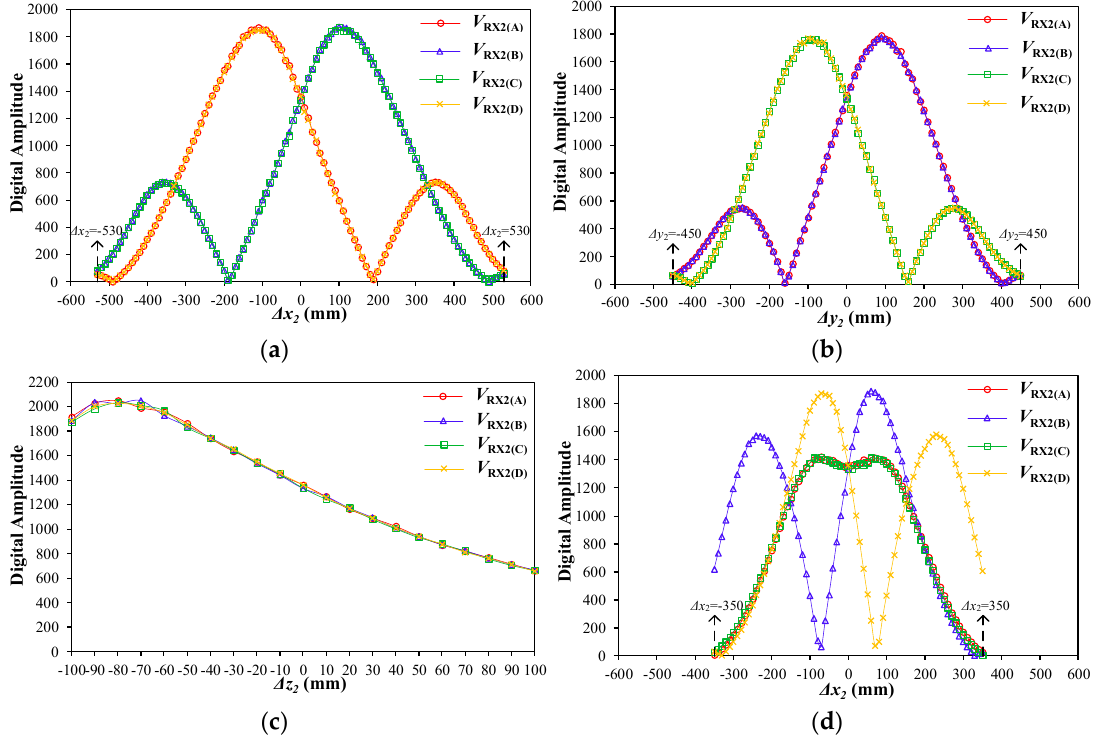
Figure 18. Measured receiving voltage amplitude when the position of secondary power coil changes along: ( a ) x axis; ( b ) y axis; ( c ) z axis; and ( d ) the line y = x in the normal air gap condition.